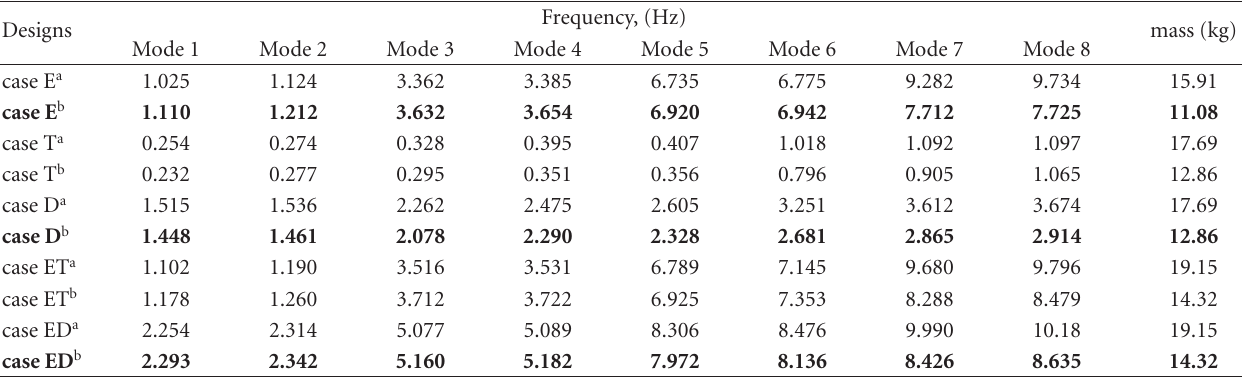
Table 1: Comparison of di ff erent design cases.